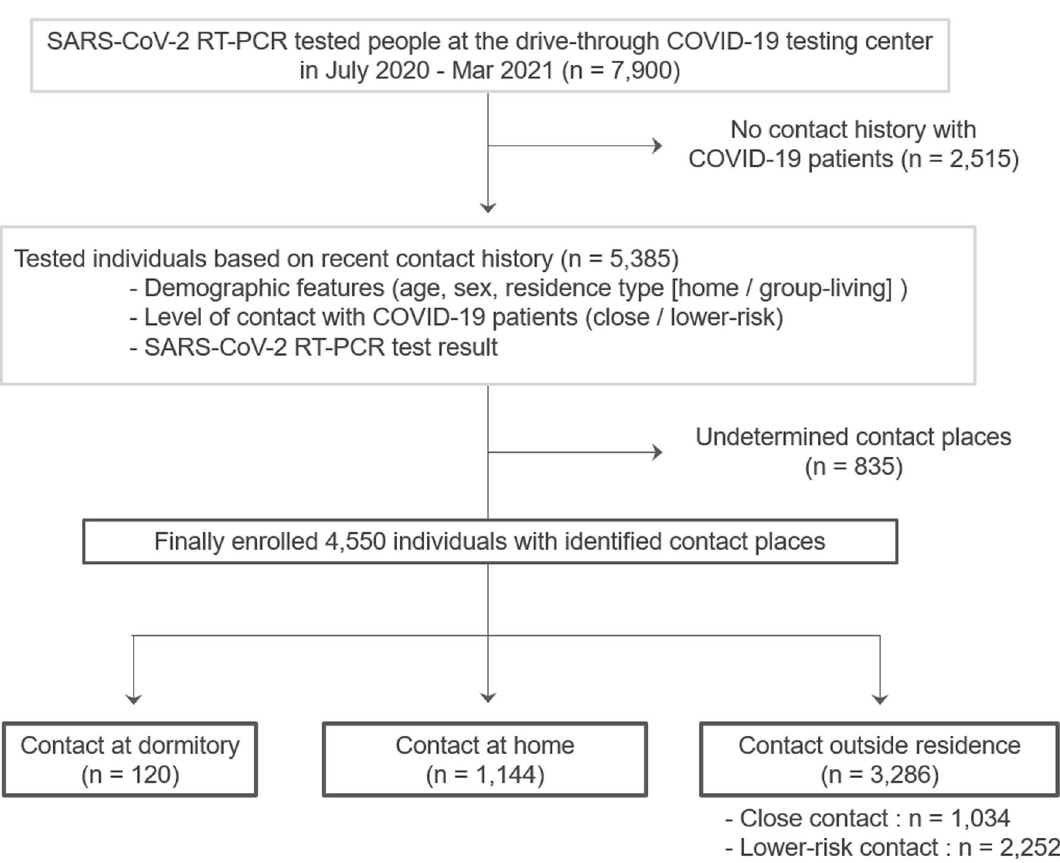
Figure 1. Study design flowchart with three groups at different contact places. The flowchart illustrates the inclusion and exclusion processes of the study and the categorization into three groups according to the different places of contact (dormitory, home, and outside residence) with the COVID-19 patients. COVID- 19, coronavirus disease; RT-PCR, reverse transcription polymerase chain reaction; SARS-CoV-2, severe acute respiratory syndrome coronavirus